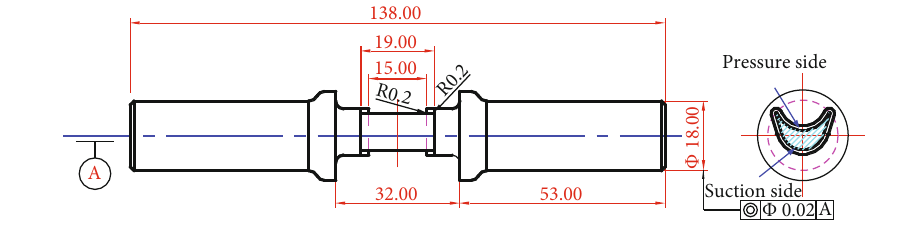
Figure 3: Layout of the designed specimen.